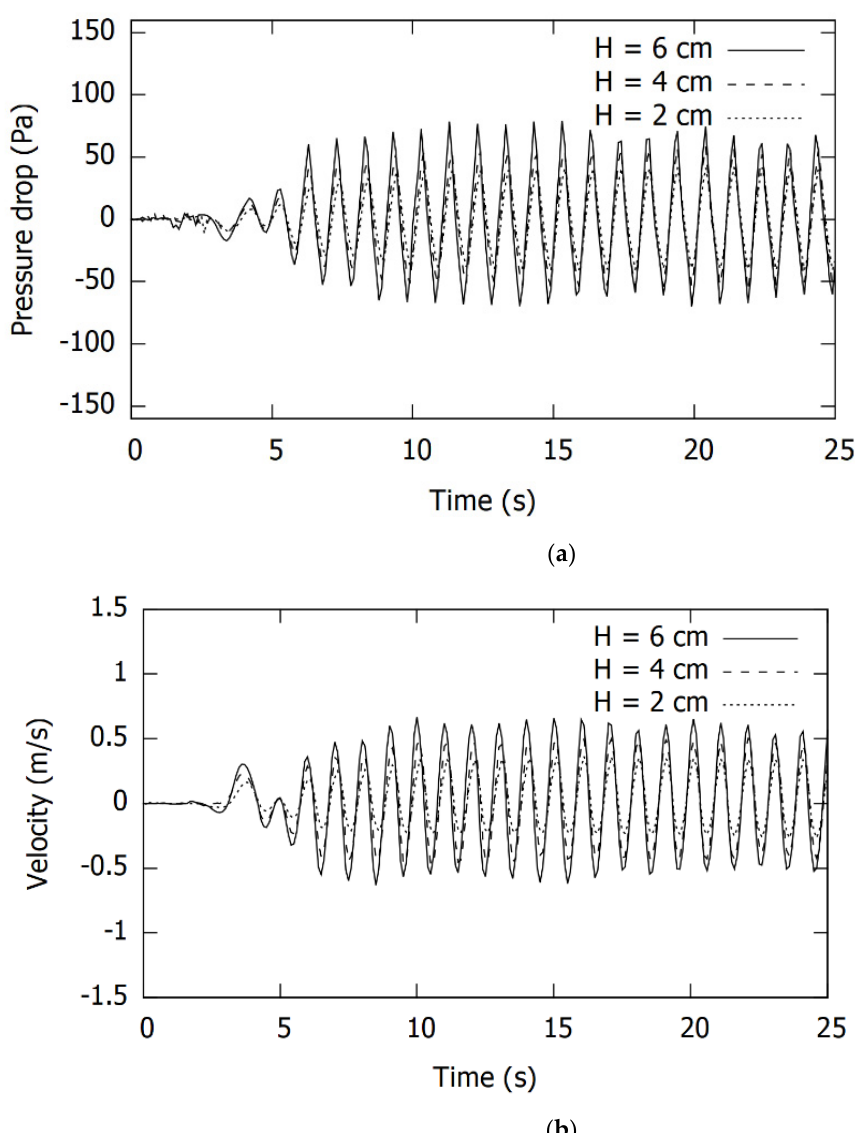
Figure 5. Effects of wave height on the ( a ) pressure drop across the pipe ( b ) velocity through the orifice.